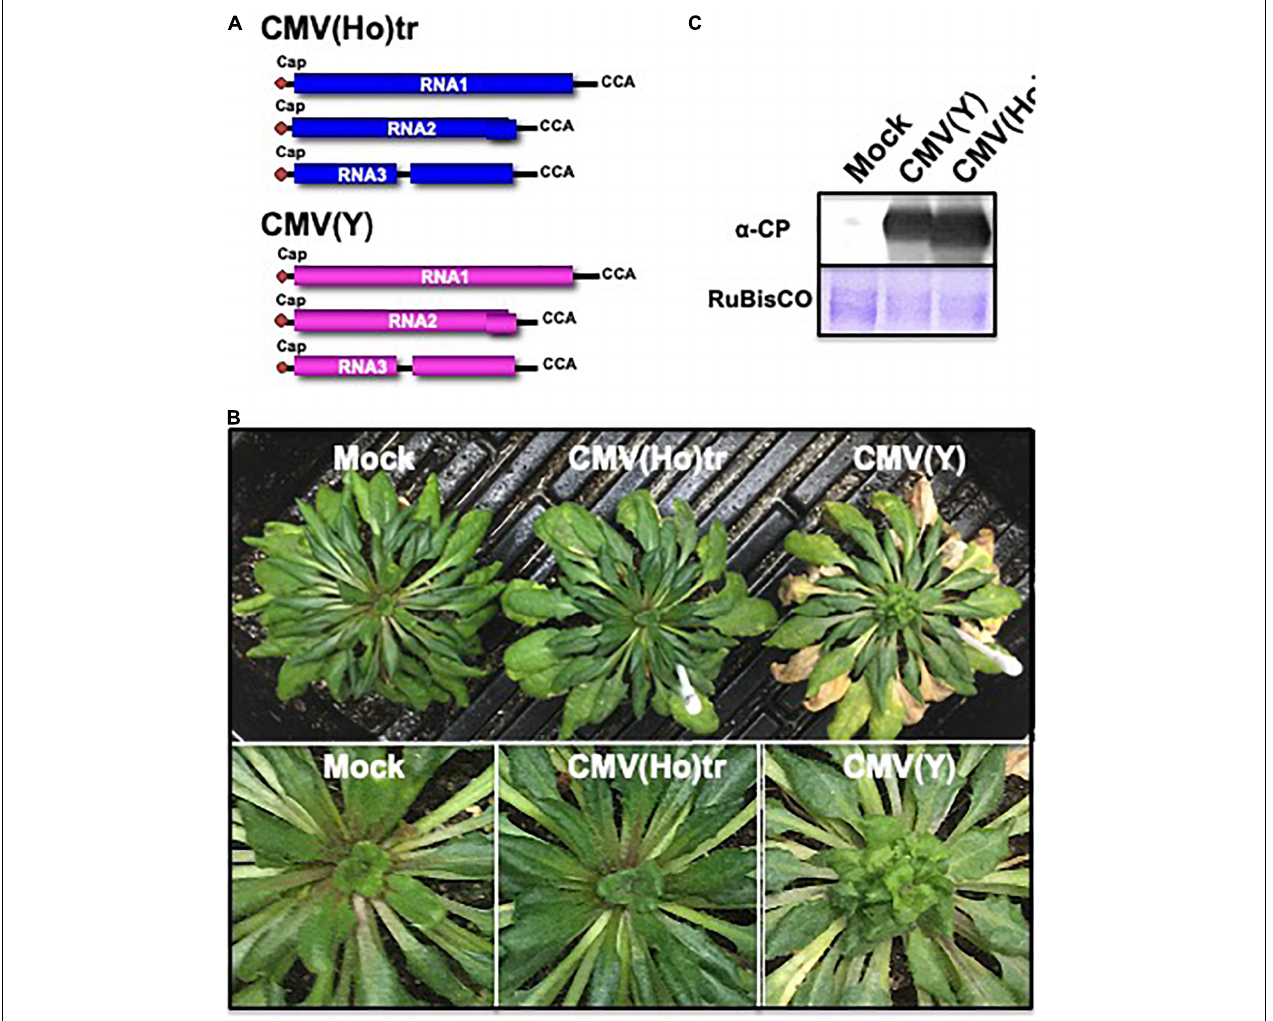
FIGURE 3 | The response of A. thaliana ecotype Col-0 to CMV(Ho)tr and virulent CMV(Y) and detection of virus coat protein in virus-inoculated leaves. Schematic structures of in vitro -transcribed RNA1, RNA2, and RNA3 of CMV(Ho)tr and CMV(Y) are shown (A) . The 5 (cid:48) -end of each RNA has a 7 mGpppG-cap structure (Cap), and the 3 (cid:48) -end of each RNA has the same nucleotide sequence (5 (cid:48) -CCA-3 (cid:48) ). At 14 dpi, CMV(Ho) tr-, CMV(Y)-, and mock-inoculated plants were photographed (B) . Enlarged photographs of non-fully expanded young leaves of each plant are shown in the lower panel. Virus coat protein in CMV(Ho) tr-, CMV(Y)-, or mock-inoculated leaves was detected immunologically at 14 dpi. As an internal control, the band of ribulose-1,5-bisphosphate carboxylase/oxygenase (RuBisCO), which was detected by Coomassie brilliant blue (CBB) staining, is shown in (C) .